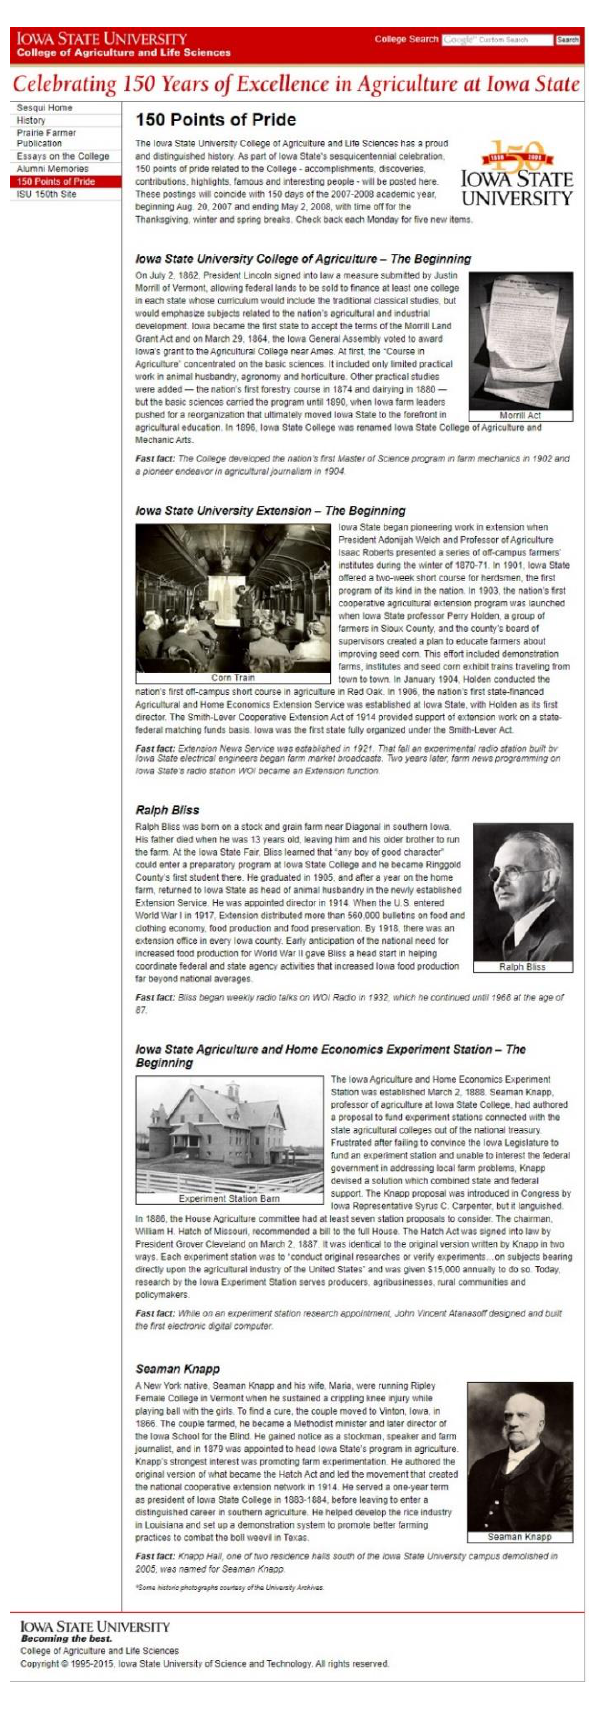
Figure A2. The web page of low aesthetic quality (Iowa State University of Science and Technology).